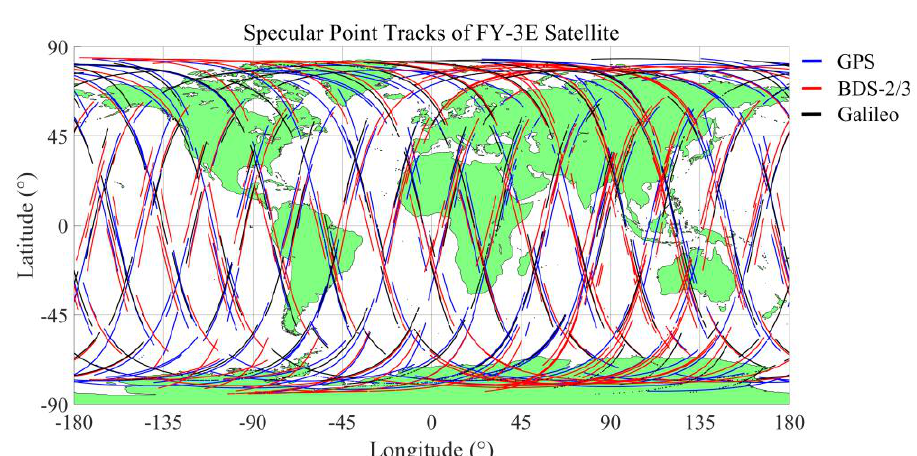
Figure 11. Global distribution of specular point tracks of FY-3E satellite in one day (17 July 2022)